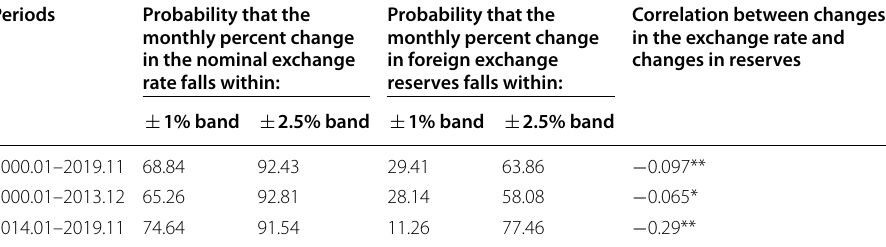
* denotes significant at 10% and ** denotes significant at 5% level. Source: based on International Financial Statistics Data